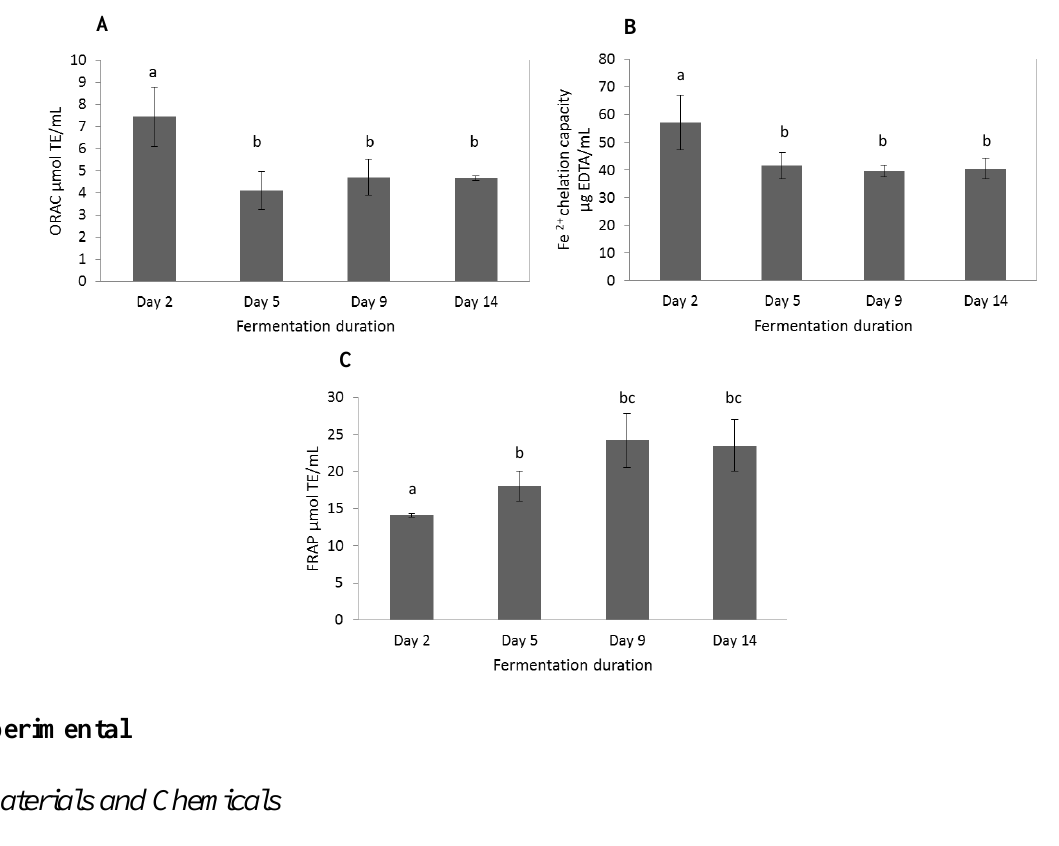
Figure 4 ． Analysis of the antioxidant capacity of radish brines during fermentation. ( A ) ORAC of radish brines expressed as µmol Trolox equivalents/mL; ( B ) Fe 2+ chelation capacity of radish brines expressed as µg EDTA equivalents/mL; ( C ) FRAP of radish brines expressed as µm Trolox equivalents/mL. Tests were conducted in triplicate, with mean values shown and standard deviations depicted by the vertical bars. Columns marked with different letters are significantly different ( p <